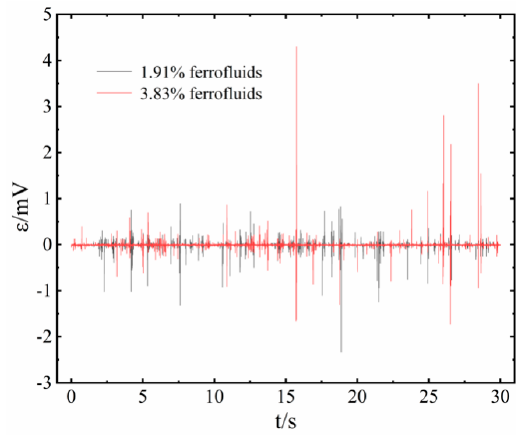
Figure 6. The output voltage of three working fluids in the heat input of 90 W.